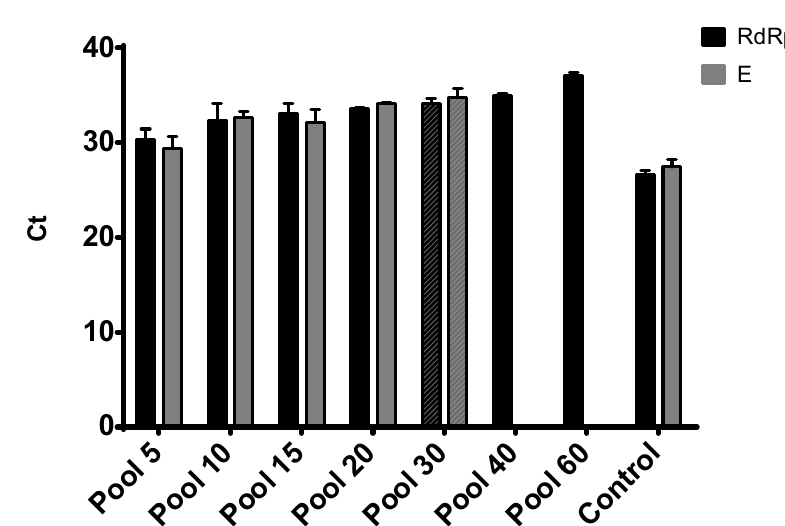
Figure 2. PCR results for the pools of 5, 10, 15, 20, 30, 40 and 60 samples using the Diatheva kit for RdRp and E genes. Results are presented as average C t ± SD from two independent experiments. Positive control is represented by the sample used for pooling.